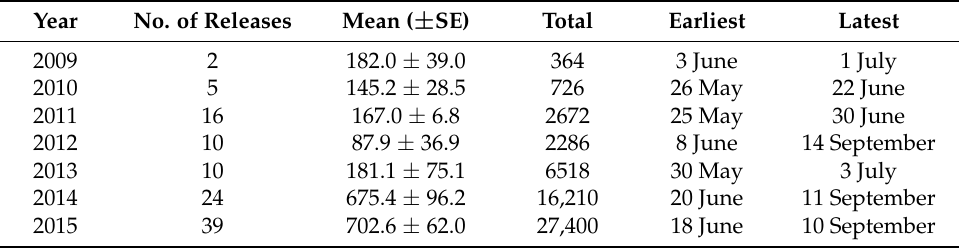
Figure 1. Map of Oobius agrili ( a ) release and ( b ) recovery sites in Maryland, USA. Nine of the 32 release sites were sampled for O. agrili recovery in the present study. Parasitized eggs were found at three of the sites sampled, and O. agrili parasitism was confirmed (through an emerging adult) from one site. Table 1. Summary of Oobius agrili releases in Maryland by year from 2009 to 2015. Shown are number of releases per year, mean ± SE O. agrili per release, total number released, and the earliest and latest date of